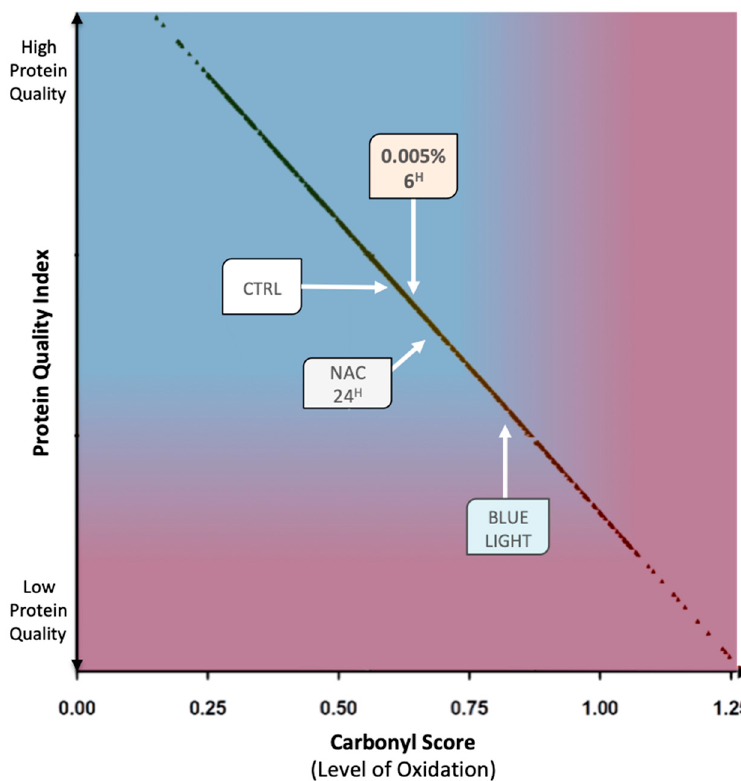
Figure 4. Protein quality index diagram. The average values for relevant experimental conditions are benchmarked against the protein quality index of the skin (more than 800 carbonyl score data points, black spots) allowing their relative positioning in a range of protein quality in function of a gradient of protein carbonylation (from low levels of carbonylation in blue to high levels in violet).